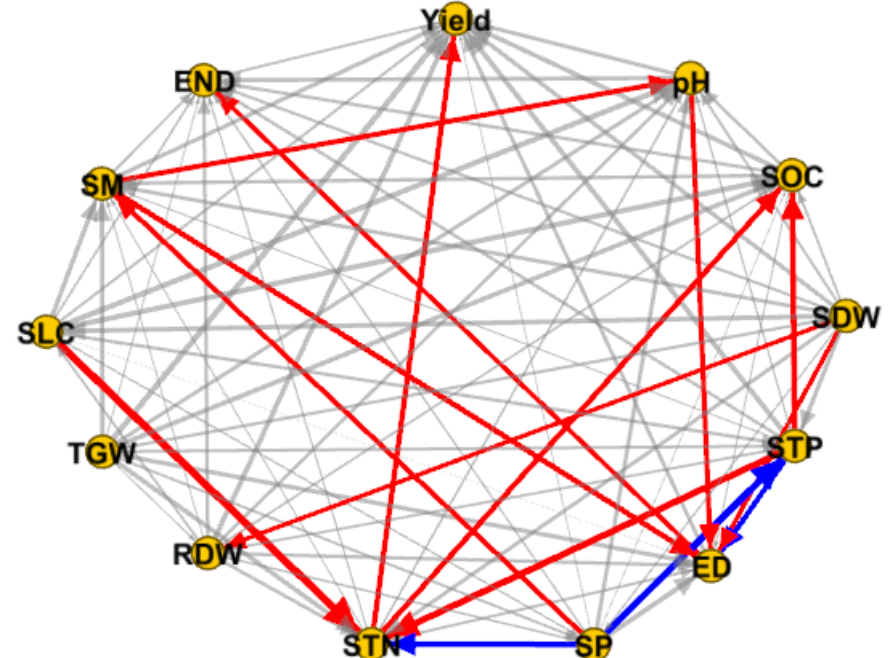
Figure 1: Network of the farmers’ CF practice. Positive and negative correlations are shown in red and blue colors, respectively. The width of the arrows represents the strength of the